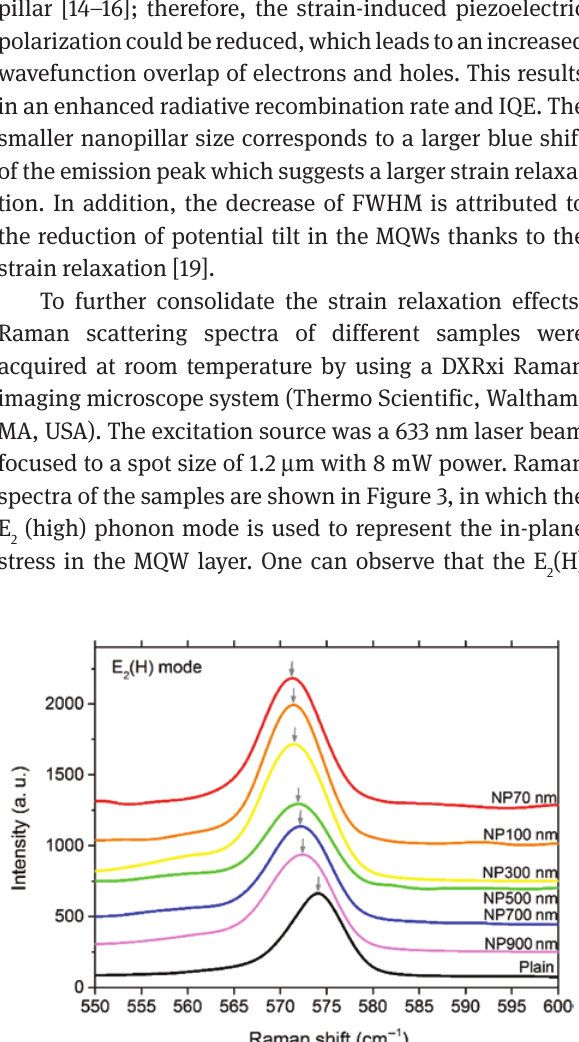
Figure 3: Raman spectra of the E nanopillar samples.